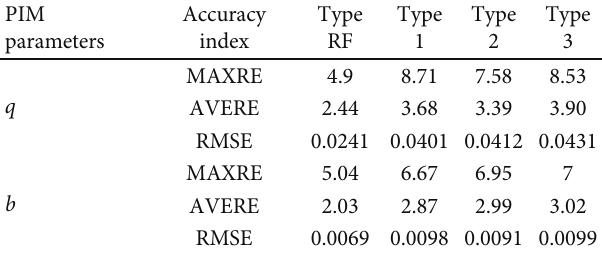
Table 7: Accuracy index values of PIM parameters under di ff erent input layer